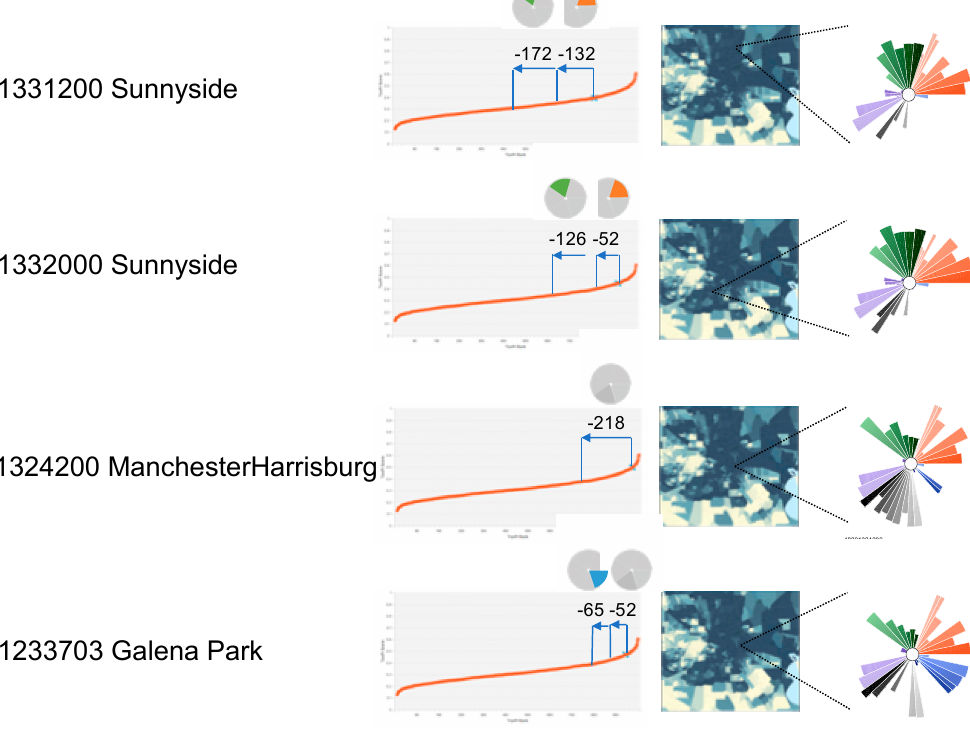
Figure 6. The ToxPi inset shows the original profile of tracts 48201331200, 48201332000, 48201324200, and 48201233703. The four rank plots show the effects on its original priority rank after ablating the effects of slices within either Social Vulnerability, Baseline Health, Environmental Sources, or Flood.